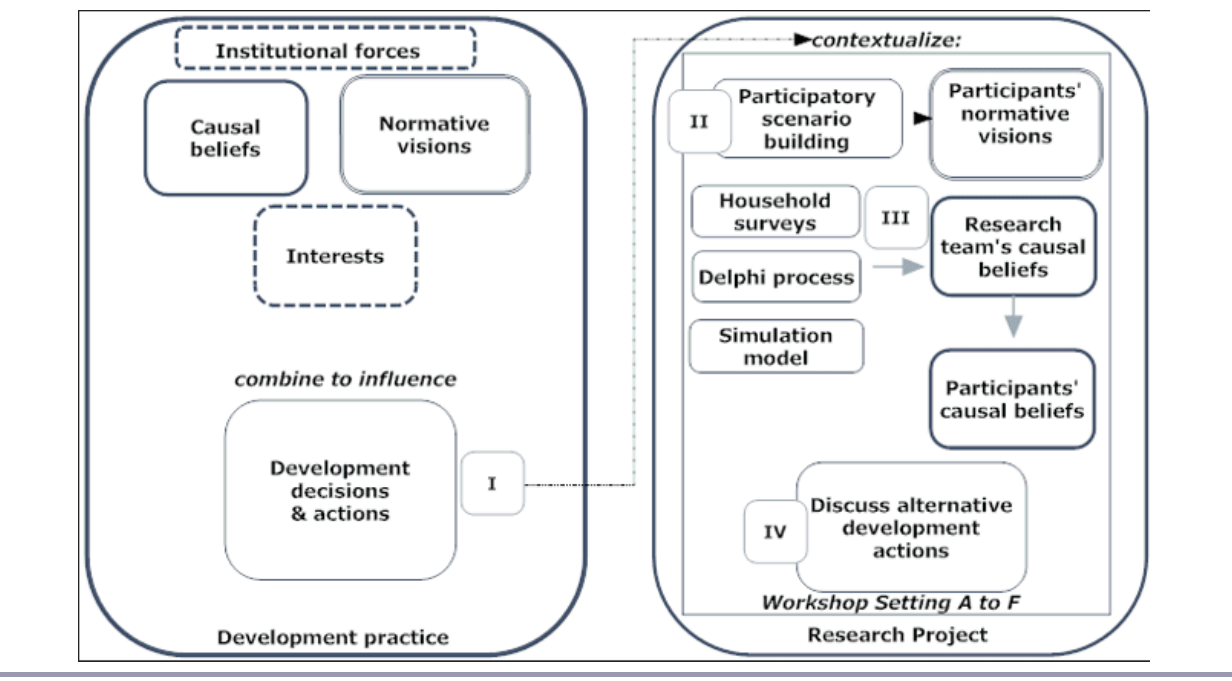
Fig. 1 . Design of the Exploring Mekong Region Futures project. Note: prevailing discourses (left hand side) influence participant visions and beliefs; connections not